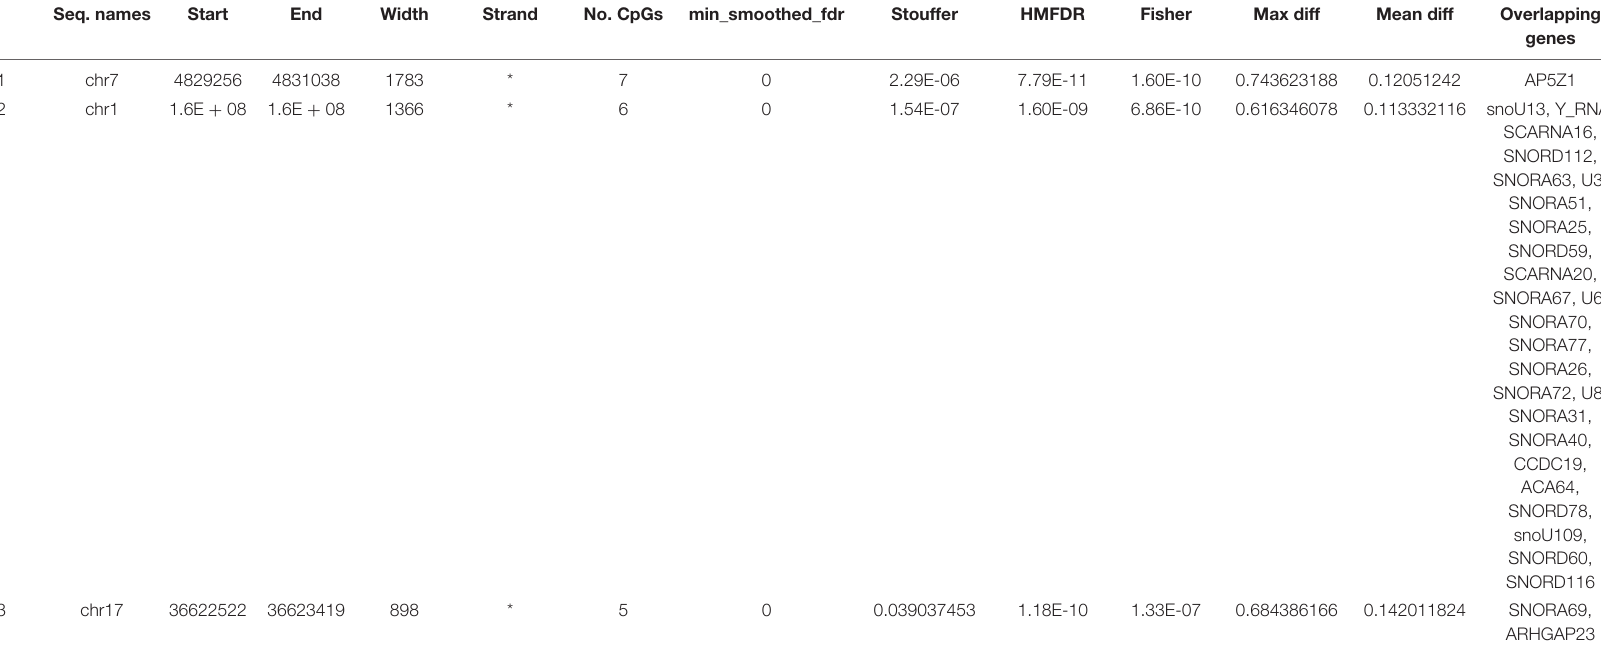
TABLE 5 | DMRs in CD8 + T cells from patient before versus after treatment with a minimum number of 5 CpG per region. Seq.